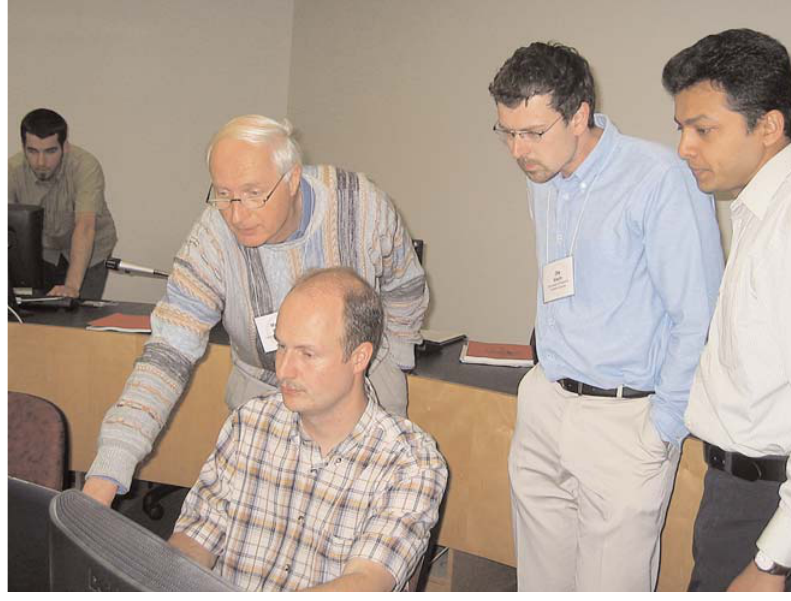
Figure 3: Manfred Wagner and Marian Mours with two